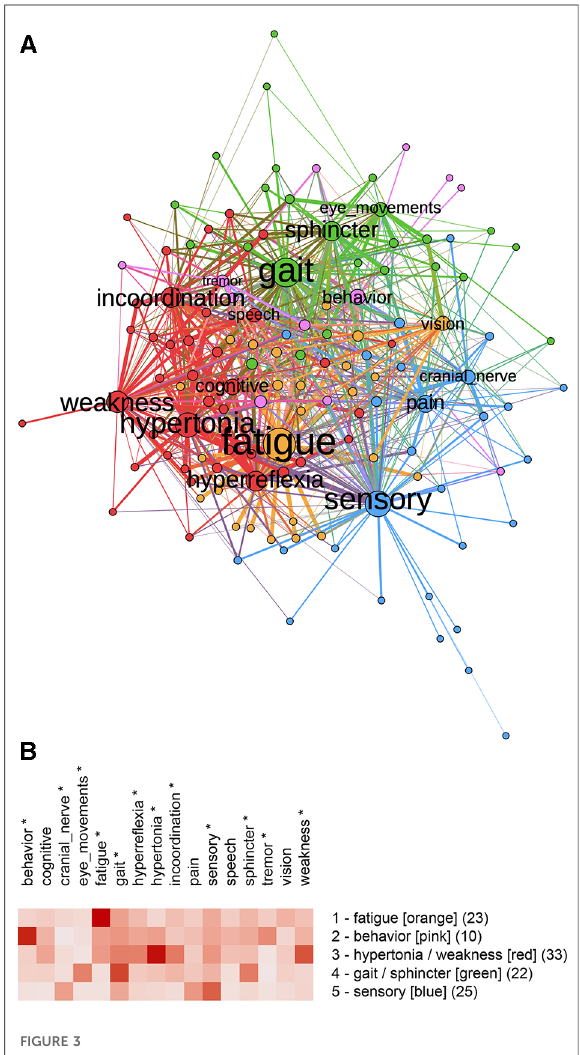
FIGURE 3 ( A ) Bipartite graph of normalized features. Labeled nodes are features; unlabeled nodes are subjects. Weighted connections (edges) are between features and subjects. ( B ) Feature map of the fi ve communities identi fi ed by partitioning the bipartite graph with unnormalized features. Modularity analysis of the bipartite graph of normalized data showed fi ve communities. Community 1 was predominantly fatigue, Community 2 was predominantly behavioral, Community 3 was weakness and hypertonia, Community 4 was gait and sphincter, and Community 5 was predominantly sensory features indicating features that differed signi fi cantly by the community (One-way ANOVA, p , 0 : 05, df ¼